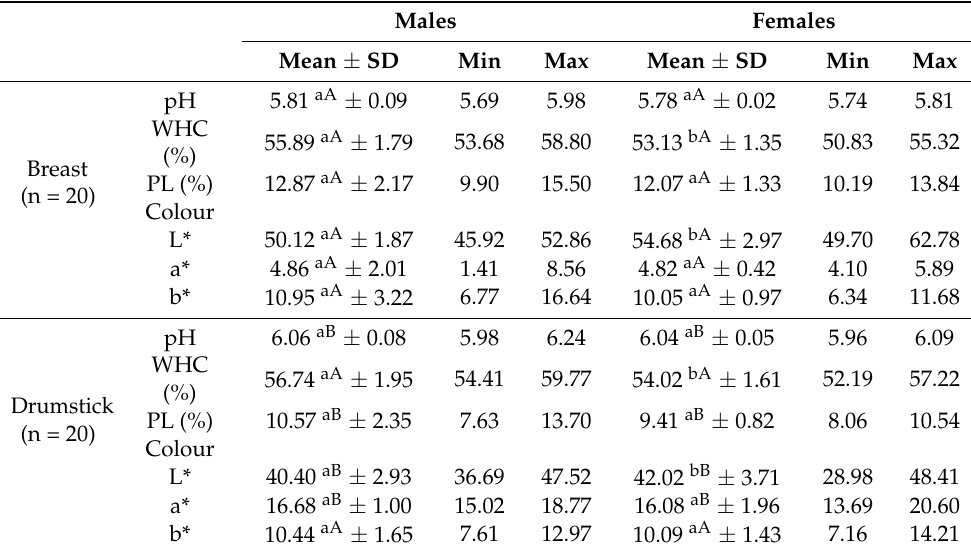
Table 2. Physicochemical traits of the breast and drumstick meat of males and females of the “Branca” breed (mean ± SD, Min and